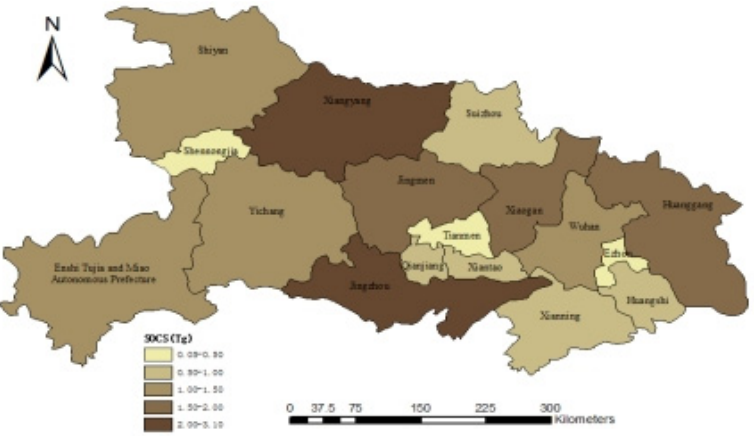
Figure 3. Spatial distribution of SOCS in Hubei Province in 2007.